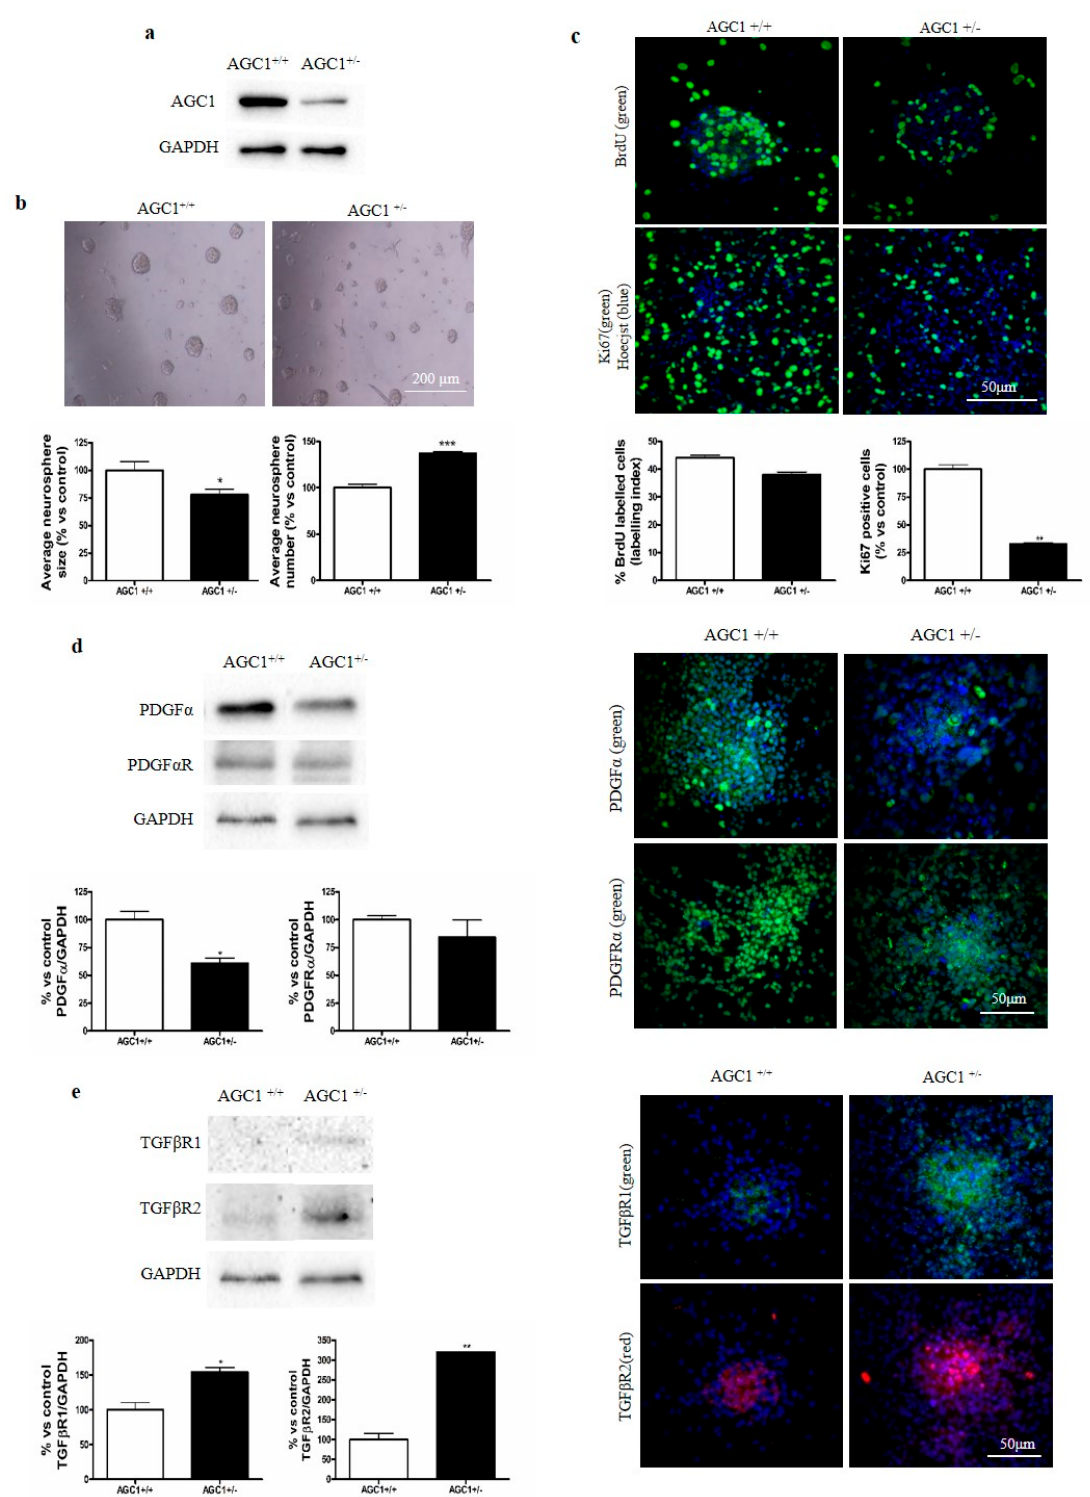
Figure 6. Altered proliferation and TGF β receptor expression in neurospheres from the SVZ of AGC1 +/+ and AGC1 +/ − mice. Western Blot analysis confirmed reduced AGC1 expression in AGC1 +/ − neurospheres compared to AGC1 +/+ neurospheres (about 65–70% reduction). GAPDH was used as an endogenous control to normalize data ( a ). Bright field microscopy images (10X) of AGC1 +/+ and AGC1 +/ − neurospheres. AGC1 +/ − neurospheres (right) showed heterogeneous morphology and appeared smaller than AGC1 +/+ neurospheres. AGC1 +/ − neurosphere cell number was also higher than AGC1 +/+ neurospheres confirmed by newly formed AGC1 +/+ and AGC1 +/ − neurosphere size and number analysis after 4 days of incubation. * p < 0.05, *** p < 0.001 compared to AGC1 +/+ neurospheres.